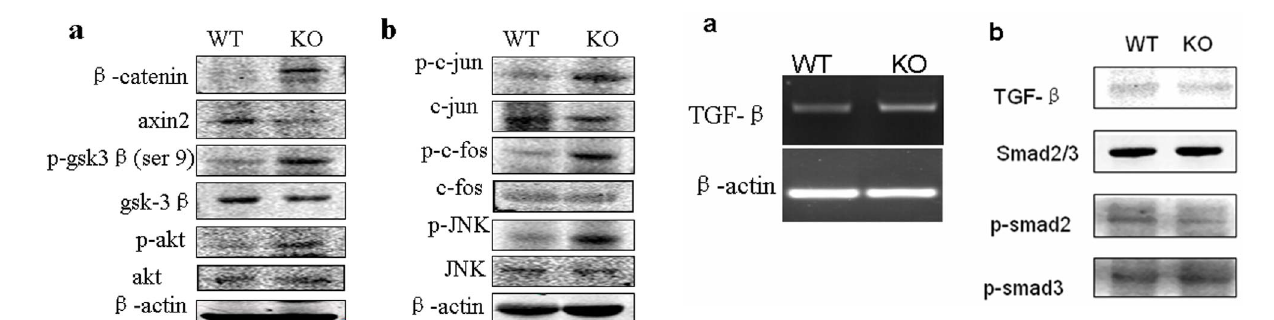
Figure 8. TGF- b 1/Smad signaling was not altered in the kidneys of Gpr48 KO mice. (a) TGF- b 1 expression in the kidney of mice was evaluated by RT-PCR. (b) The phosphorylated forms of smad2 and smad3 were analyzed by western